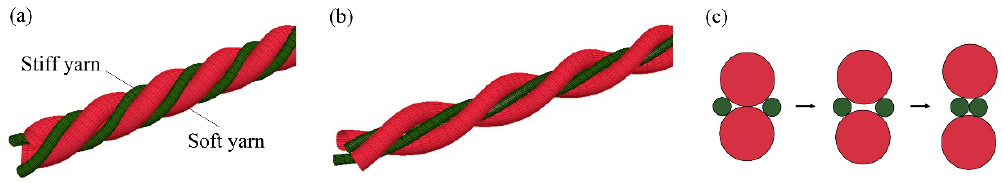
Figure 1. Four-ply auxetic yarn: ( a ) at rest; ( b ) under extension; and ( c ) cross-section views in different stretched states.